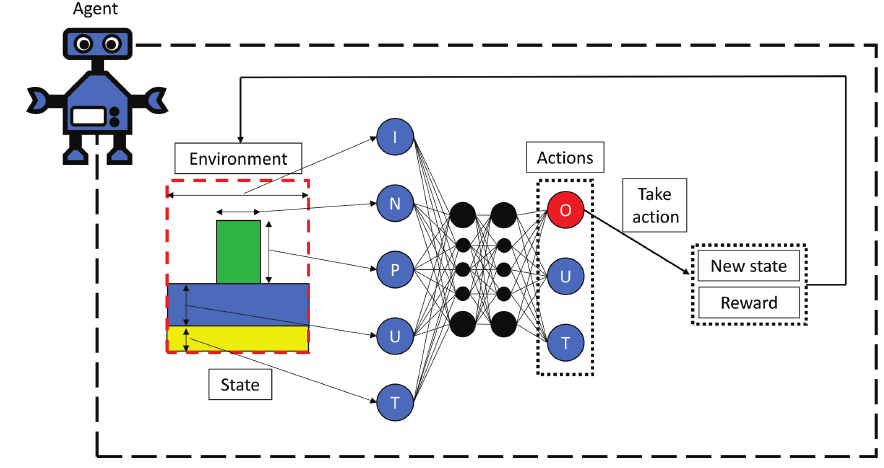
Figure 7: A schematic of the main features of reinforcement learning for nanostructure inverse